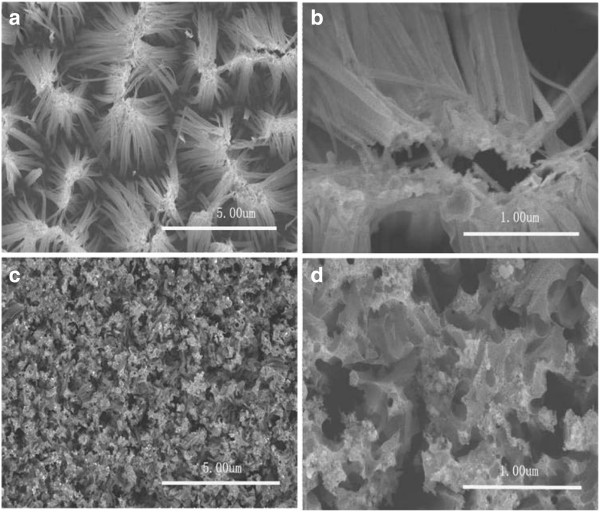
SEM images of SiNWs with different H2O2 contents: (a, b) 20% and (c, d) 30%.